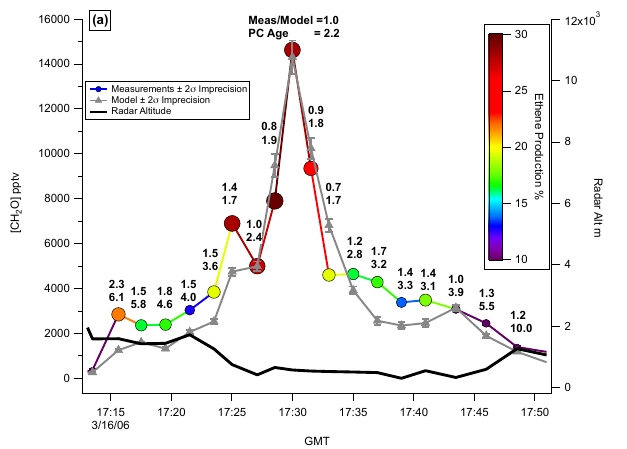
Fig. 11b. TDLAS measurement/model ratios as a function of pho- tochemical age for the same data shown in Fig. 11a (16 March 2006), which are colored and sized by the ethene production per- centage. The error bars are the combined 2 σ measurement-model imprecision limits. The blue curve (Profile 1) is a 3-term polyno- mial regression fit of 15 data points (photochemical age ≤ 6.1 h and ethene production percentage ≥ 12%). The red profiles display the expected behavior of the box model using a Lagrangian model to simulate the time dependent behavior due to various VOC emis- sions in the morning (see text) in the presence of variable NO x (0 to 25ppbv). The ratio of the Lagrangian to box model CH 2 O is plot- ted as a function of photochemical age. At processing times longer than ∼ 6h and/or lower ethene emission percentages, other sources of CH 2 O become dominant and these are displayed by the inset, which utilizes the same axes as the main plot. A linear fit of the inset points yields: intercept = 1.35 ± 0.1, slope = − 0.002, r 2 of